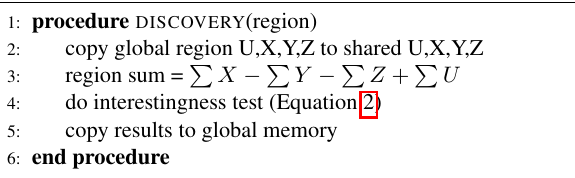
Algorithm 2 : High Level Block based discovery